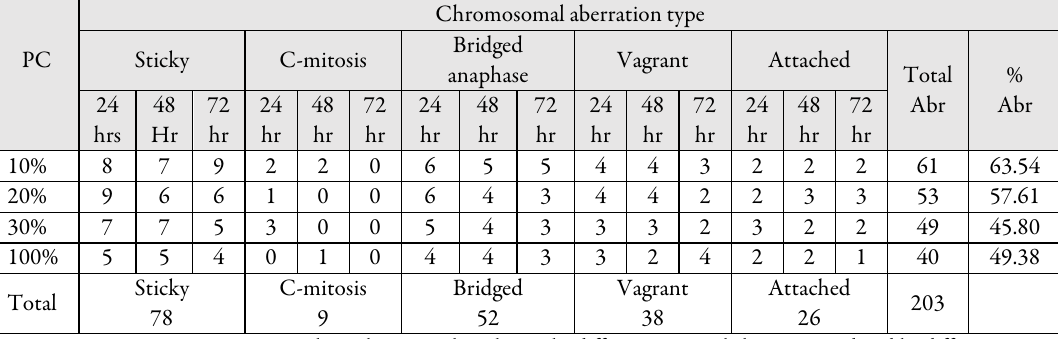
Table 4. Major chromosomal aberrations induced in A. cepa root cells exposed to different